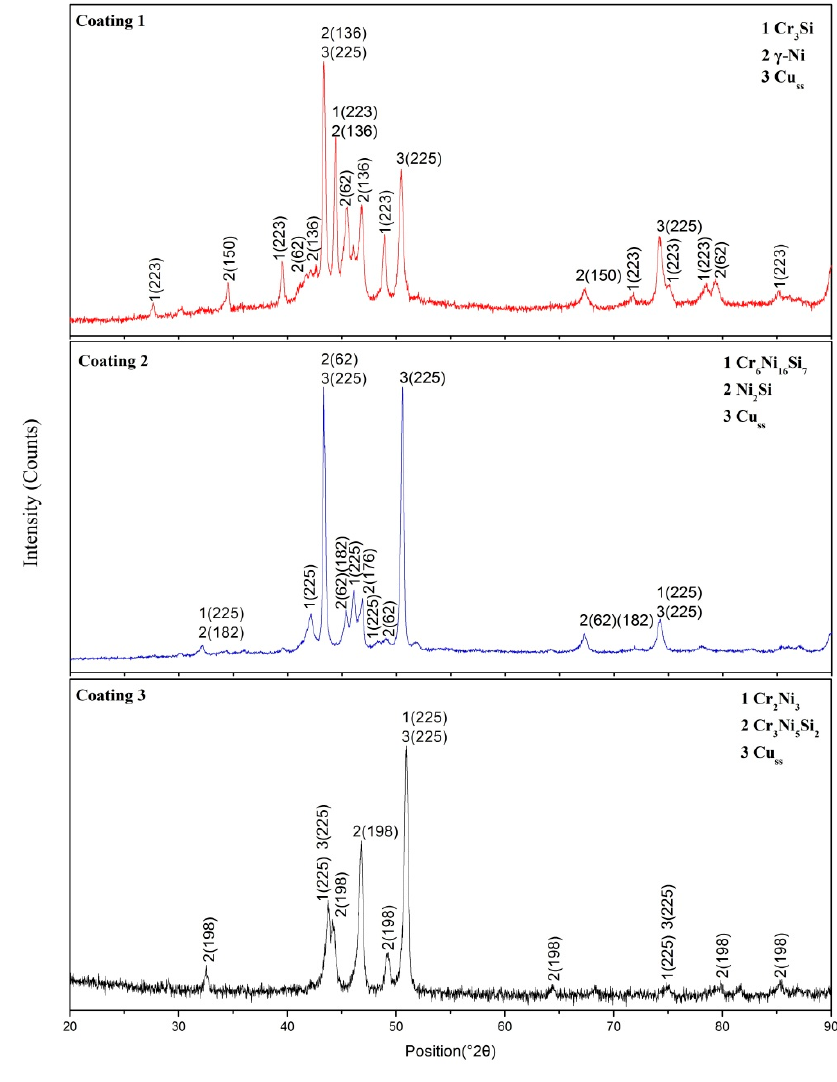
Figure 3. X-ray diffraction (XRD) patterns of the laser cladding coatings with Coating 1, Coating 2, and Coating 3.